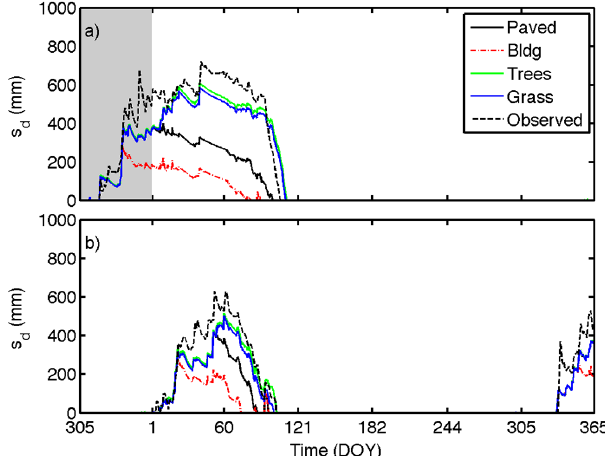
Figure 7. Simulated (by surface type) and observed snow depth in Helsinki in (a) 2011 and (b) 2012. The grey area shows the spin-up period.